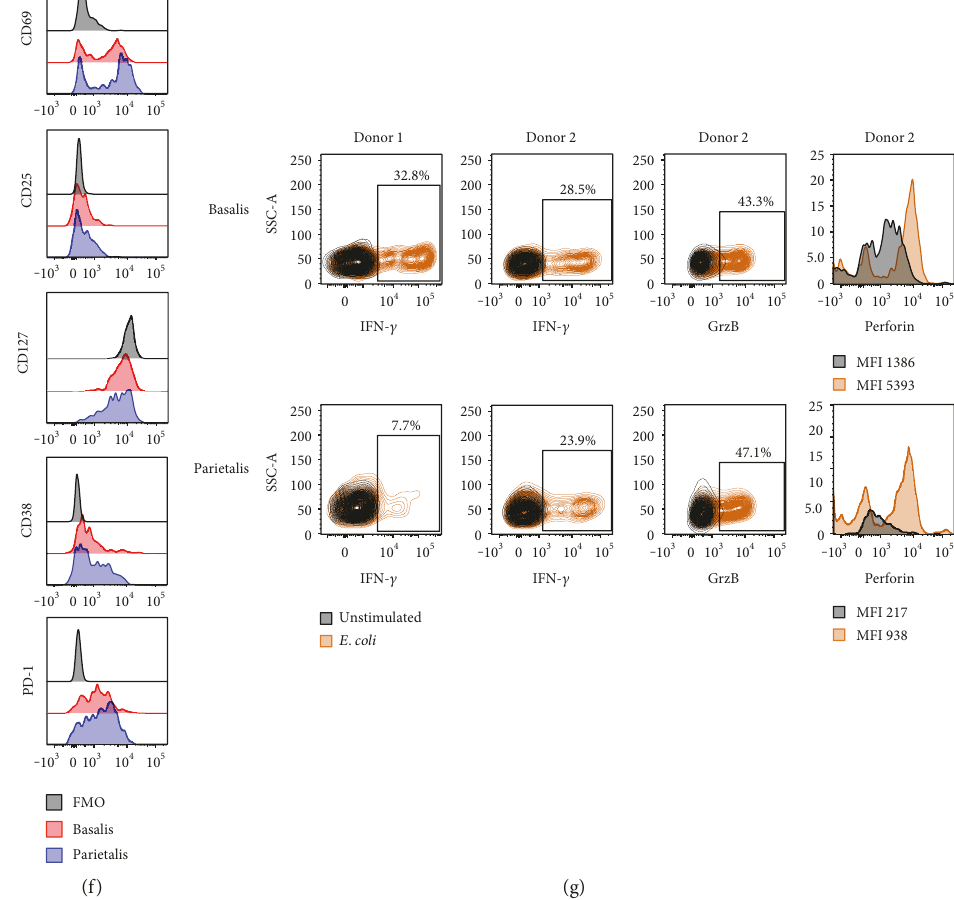
Figure 3: MAIT cells in decidua basalis are more numerous, but parietalis MAIT cells display a more activated phenotype. (a) Representative fl ow cytometry plots showing the gating strategy for MAIT cells based on CD3 + T cells (left to right). (b) OPLS plot showing associations between decidual compartment and phenotypic MAIT cell markers ( n =8 – 13). (c) Number of MAIT cells expressed as percentage of CD3 + T cells in paired samples of decidua basalis and parietalis ( n = 13 ). (d) MAIT cell surface expression of CD4 and CD8 in paired samples of decidua basalis and parietalis ( n = 13 ). (e) MAIT cell surface expression of CD69 ( n = 12 ), CD25 ( n = 10 ), CD127 high ( n = 8 ), CD38 ( n = 10 ), and PD-1 ( n = 10 ). (f) Representative histograms showing the expression of the indicated extracellular markers on MAIT cells from decidua basalis and parietalis compared to the fl uorescent minus one (FMO) control. (g) Contour plots and histograms showing the expression of the indicated intracellular molecules on decidua basalis (top) and parietalis (bottom) in unstimulated (black) compared to the E. coli stimulated conditions (orange) for interferon- γ (IFN- γ , n = 2 ), granzyme B (GrzB, n = 1 ), and perforin ( n = 1 ). Line in graphs depicts the median. Comparisons between the paired samples were made using the nonparametric Wilcoxon test. ns=not signi fi cant; ∗ p < 0 05 ; ∗∗ p < 0 01 ; ∗∗∗ p < 0 001